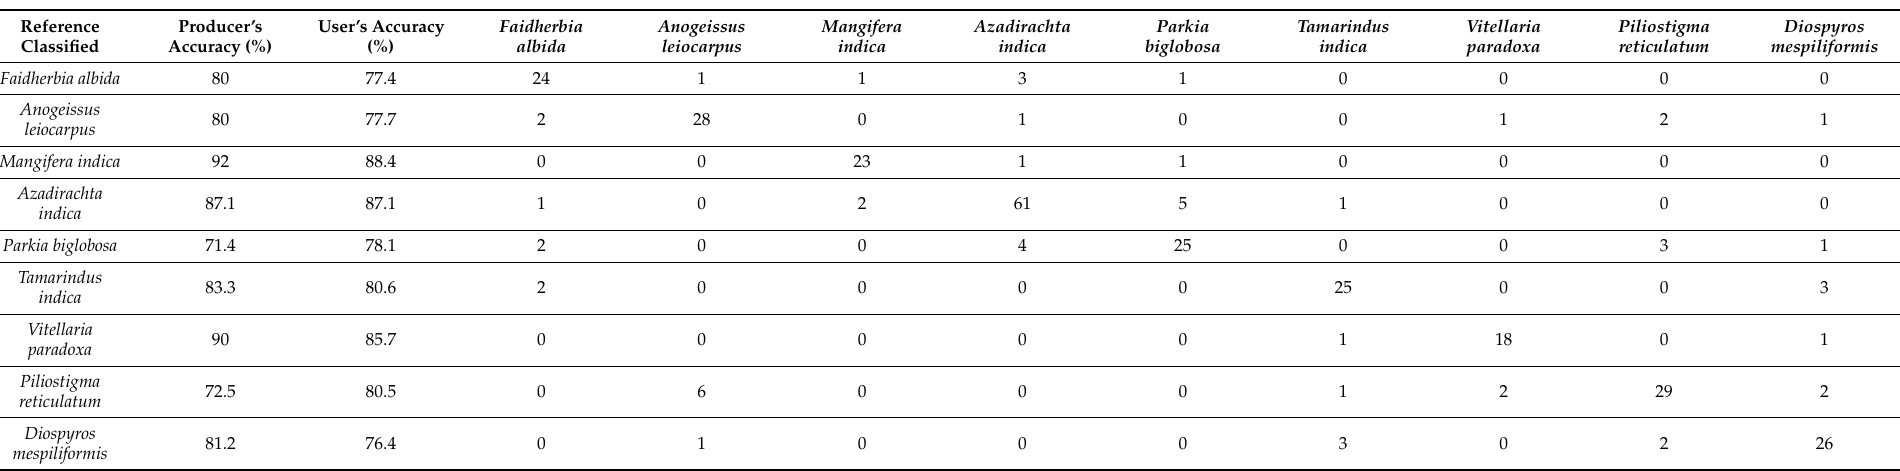
Table 5. MLP-based confusion matrix showing producer and user accuracy for nine dominant tree species. Row sums are equal to the number of sampled tree species after applying SMOTE.